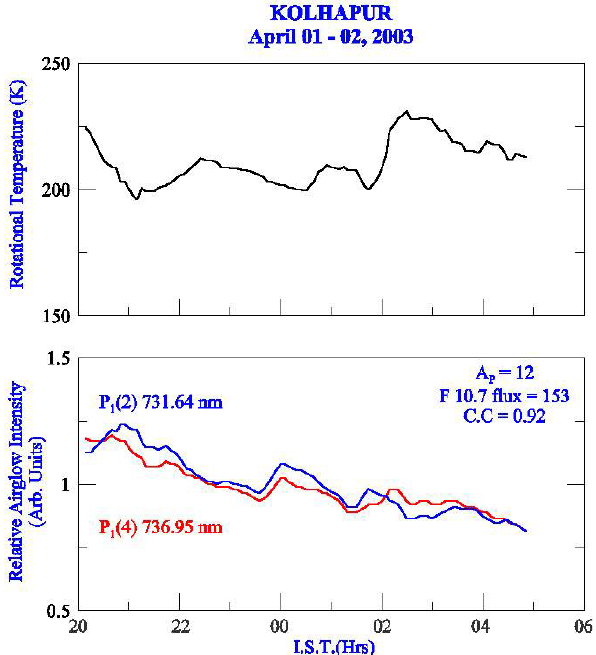
Fig. 1a. The relative intensity of the P 1 (2) and P 1 (4) lines is shown as well as the rotational temperature calculated from the ratio of the intensity of two lines for the night of 1–2 April 2003 at Kolhapur.